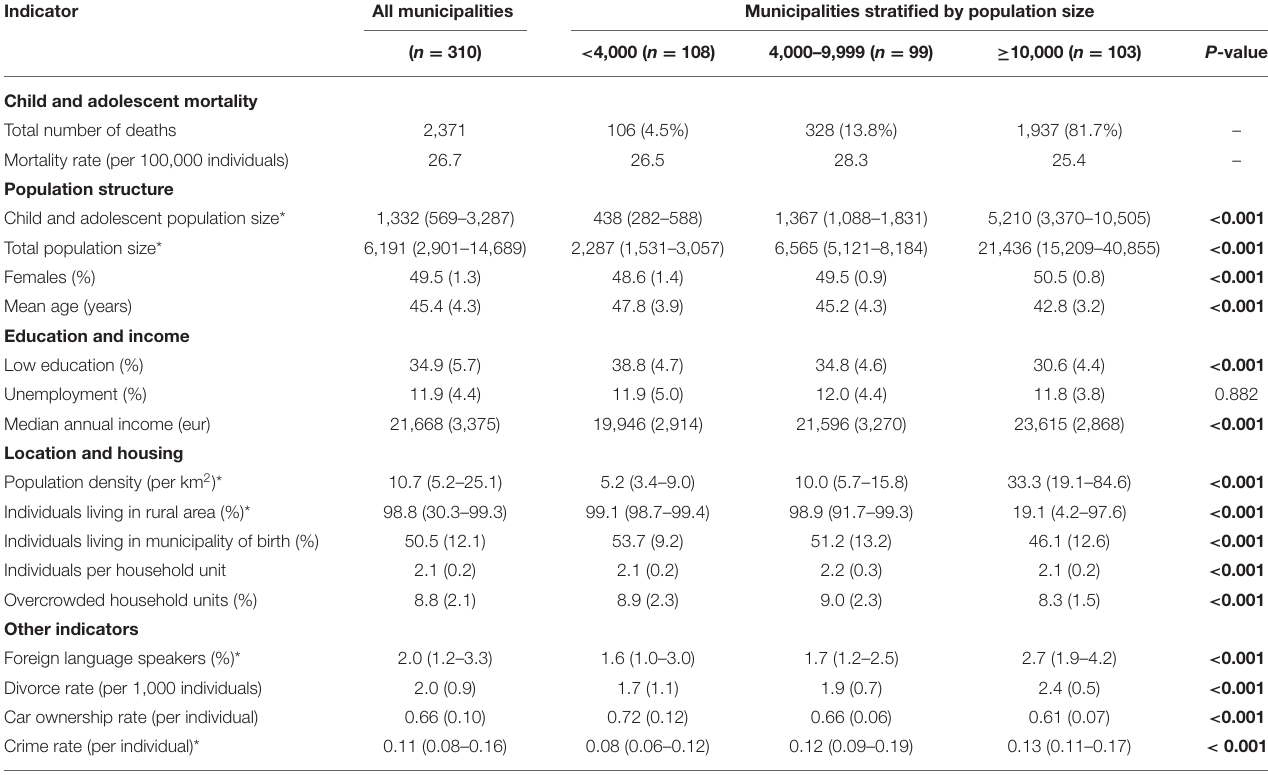
TABLE 1 | Sociodemographic characteristics of the municipalities. Indicator All